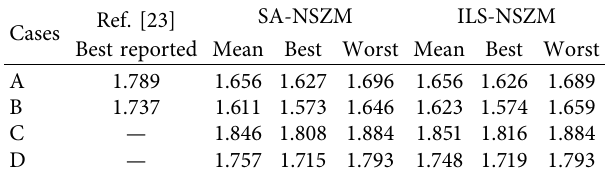
Table 1: Objective functions in millions of USD.